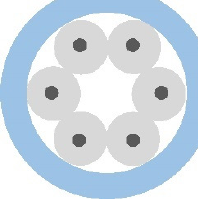
Figure 3 The cross-section diagram of hollowed fiber bundle waist region. Figure 3. The cross-section diagram of hollowed fiber bundle waist